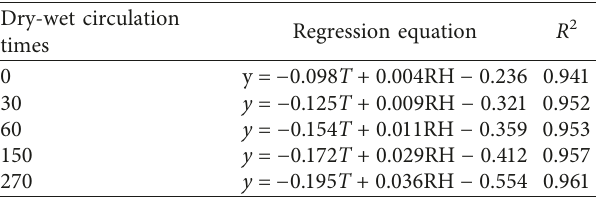
Table 4: Hygroscopic kinetic parameters affected by temperature and relative